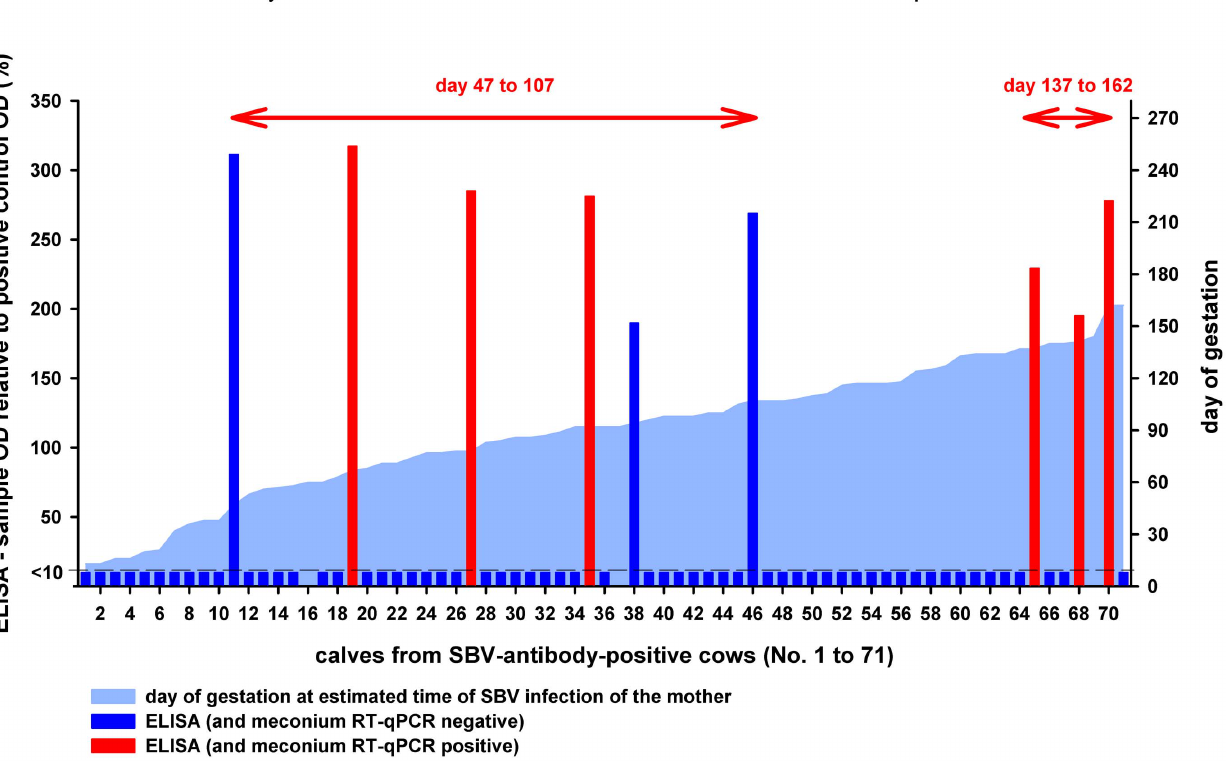
Figure 1. Detailed analyses of newborn calves in 2 farms in North Rhine-Westphalia. Meconium samples of calves whose ELISA results are marked in red tested positive by real-time RT-PCR; blue ELISA results correspond to negative PCR results. The day of gestation at the estimated time of SBV-infection of the respective cow is symbolized by a light blue area.